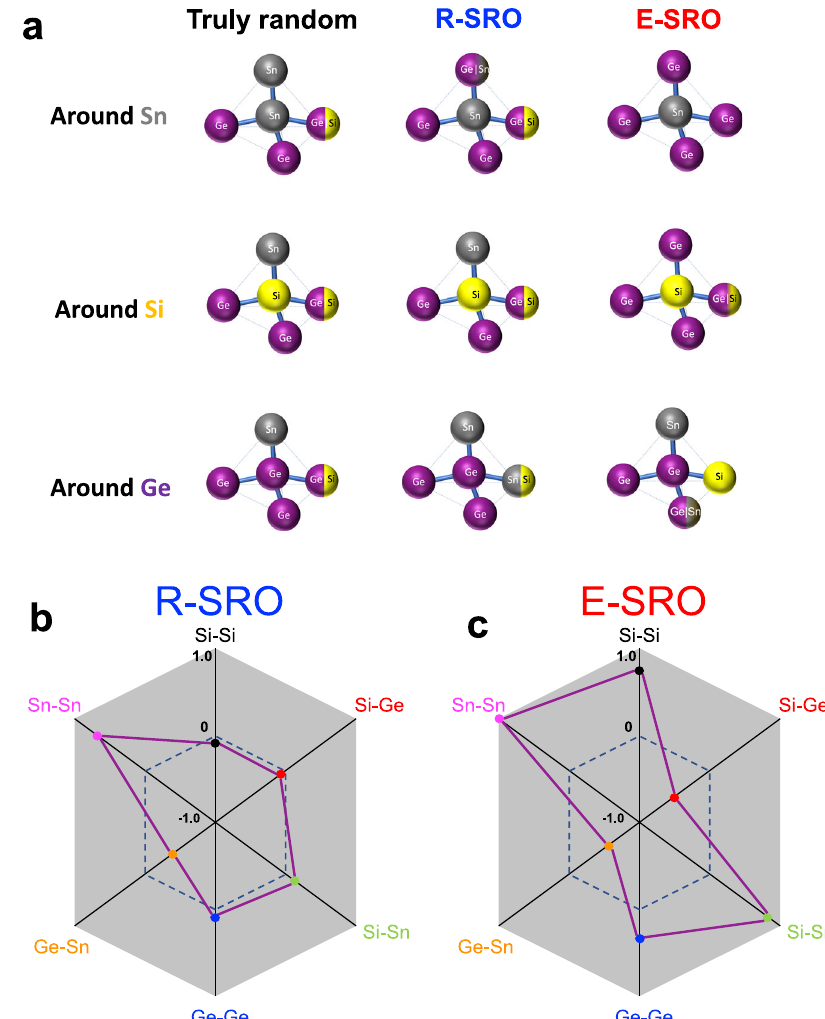
Fig. 2 Structural signatures of R-SRO and E-SRO in Si 0.125 Ge 0.625 Sn 0.25 . a The averaged local tetrahedral structural motif around each alloying element when the alloy adopts a random distribution, R-SRO and E-SRO. b , c Show the SRO polygons constructed from the averaged SRO parameter α 1 ij for each type of nearest neighbor in R-SRO and E-SRO, respectively. The averaged SRO parameter α 1 ij for the pair i − j is depicted as a dot on the axis labeled as i − j , with its location determined by the value of α 1 ij . An SRO polygon (purple solid lines) is obtained through connecting the six dots. The dashed-hexagon represents a random distribution where α 1 ij ¼ 0. It is visibly clear that only Ge – Sn and Sn – Sn in R-SRO display substantial deviations from the random distribution, whereas the six types of pairs in E-SRO all show strong non-random